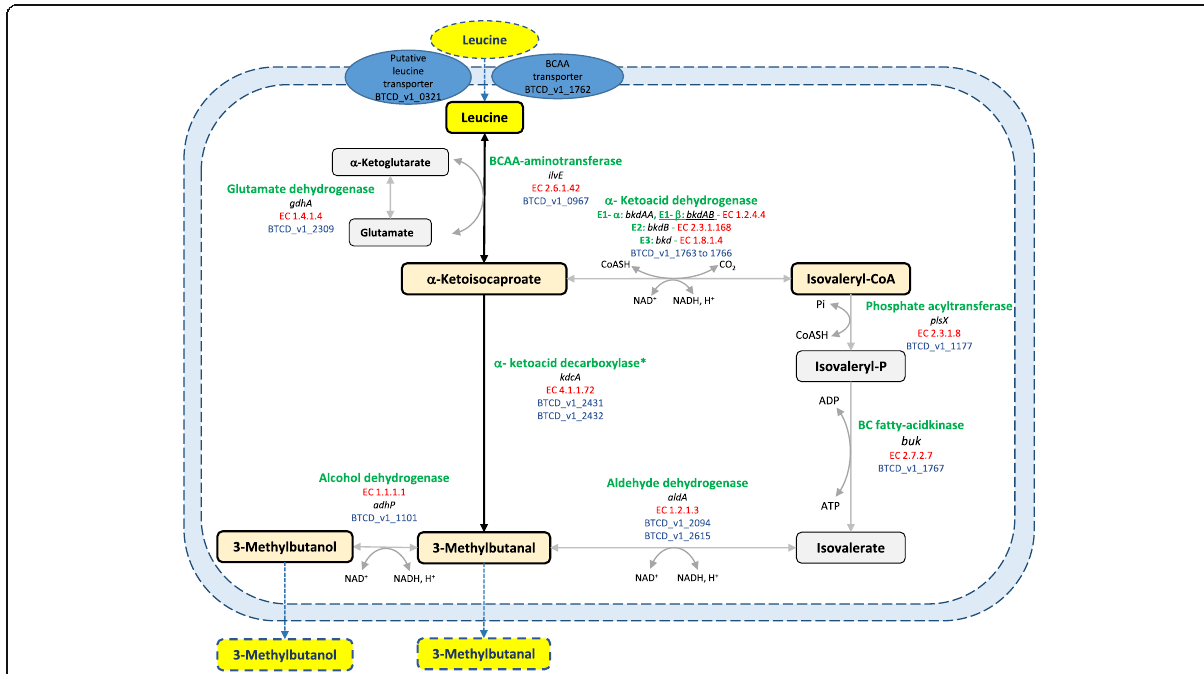
Fig. 5 Probable metabolic pathway for the biosynthesis of 3-methylbutanal from L -leucine degradation by B. thermosphacta. All the genes encoding the necessary enzymes for the direct (dark line) and the indirect (gray line) pathways were present. Alcohol dehydrogenase was also present. BCAA refrers to branched-chain amino acids. *The kdcA gene is fragmented in B. thermosphacta CD 337. The underlined gene bkdAB is fragmented in BSAS1